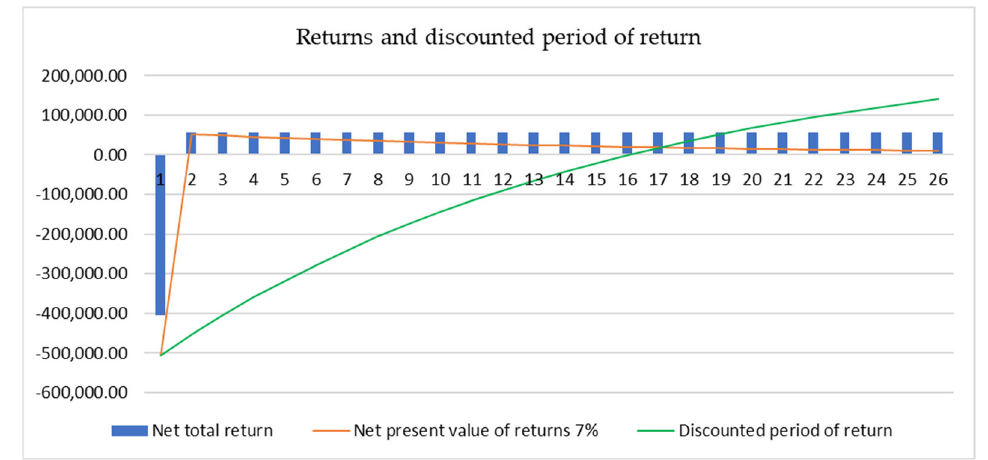
Figure 10. Economic indicators of location Kranj.